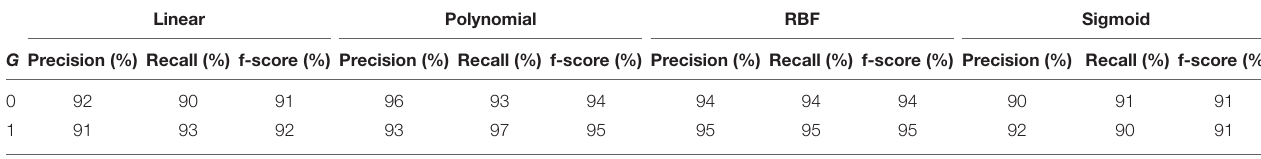
TABLE 2 | Precision, recall, and f-score for G =0 and G =1 of the 4 support vector machine kernels. Linear Polynomial RBF